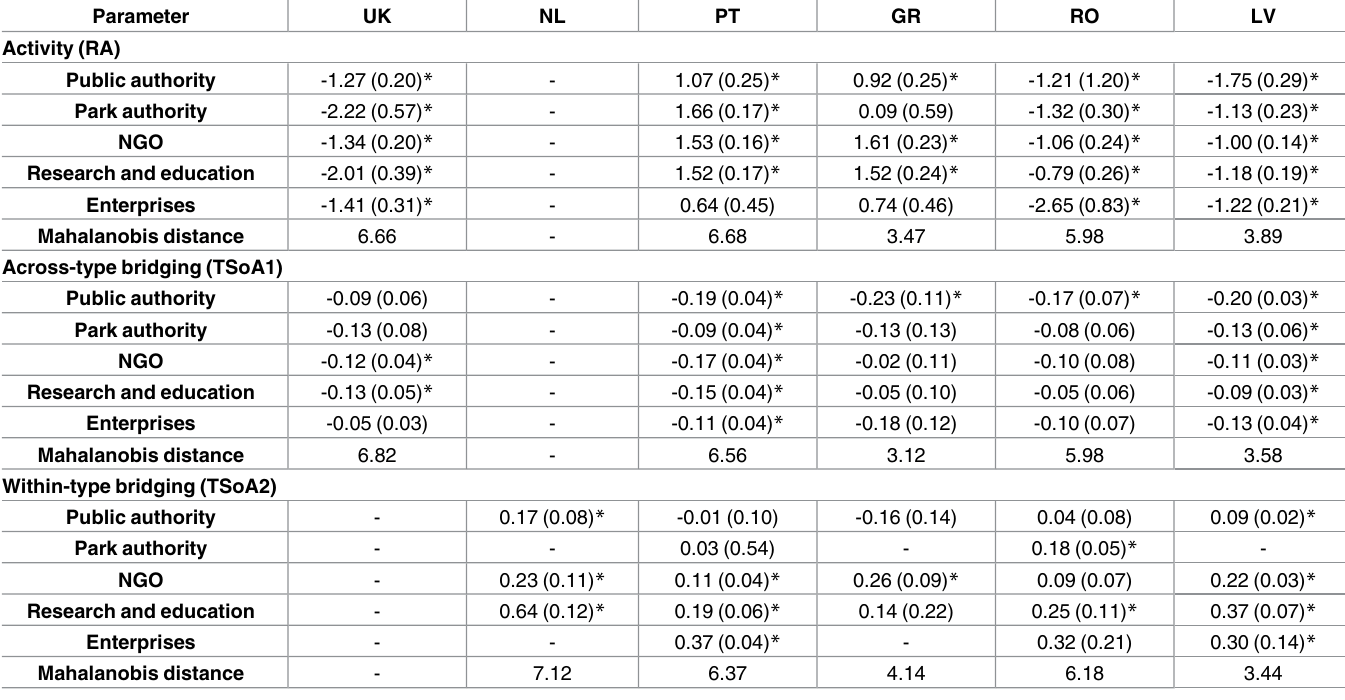
Table 3. Within–node ERGMs for selected LIFE Nature partnership